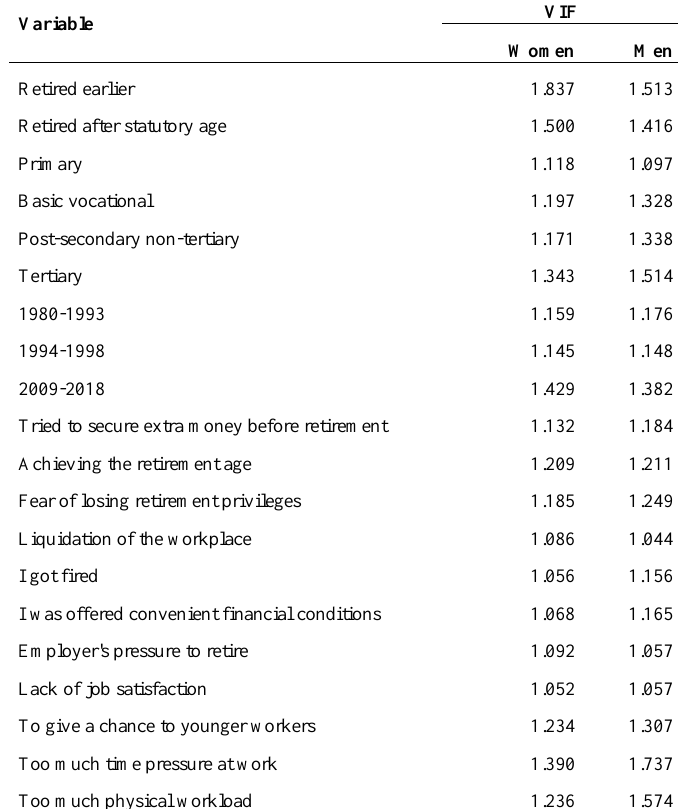
Table 3. Variance Inflation Factor values of variables used in the models